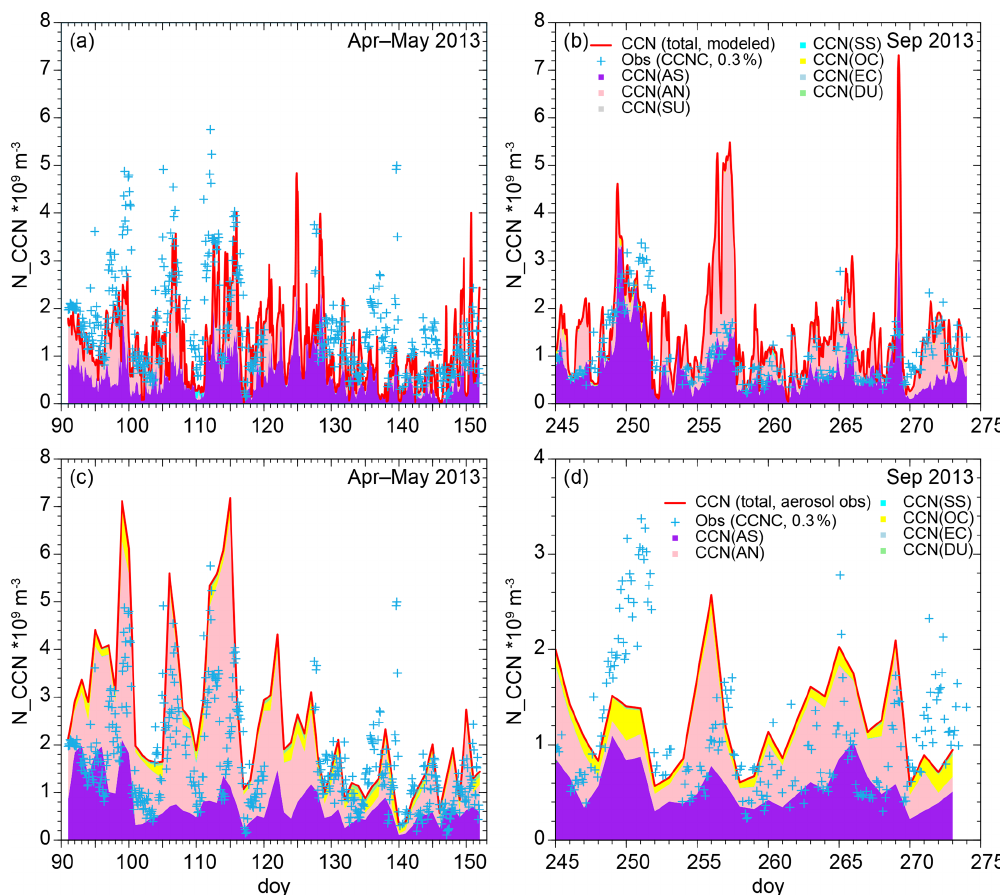
Figure A1. Simulated and measured CCN number concentrations in Melpitz at a supersaturation of 0.3% during the two HOPE campaigns (April to May and September 2013). Panels (a) and (b) show the CCN number concentrations resulting from the simulated aerosol concentra- tions, while panels (c) and (d) show the CCN numbers resulting from measured aerosol concentrations using the same CCN parametrization. The colors represent the contributions to CCN of different species. The blue crosses indicate the CCN number concentrations using the CCNC. Please note the different time resolution for the observations and the different scale for the CCN number concentration in plot (d)